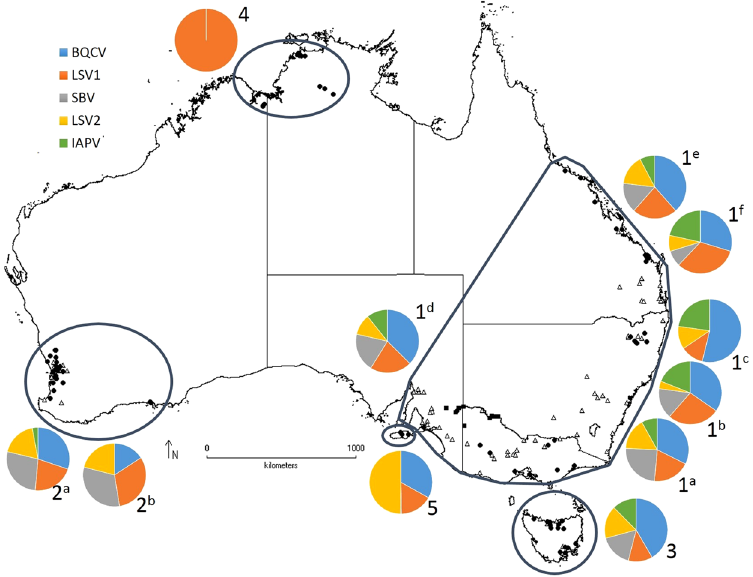
Figure 1. Map of Australia showing sampling sites ( ● ) and apiary origins ( ▲ ) across five regions (1–5) and prevalence of five honeybee viruses detected by RT-PCR in adult honeybee samples. Samples for Region 1 include: a, VIC/NSW-1 August 2013; b, VIC/NSW-2 April 2014; c, VIC/NSW-3 August 2014; d, SA August 2014; e, QLD August 2013; f, QLD October 2014. Samples for Region 2 include g, WA-1 October 2013; h, WA-2 March 2014. Region 3–5 were comprised of single sampling periods. Map was created using DIVA-GIS version 7.5